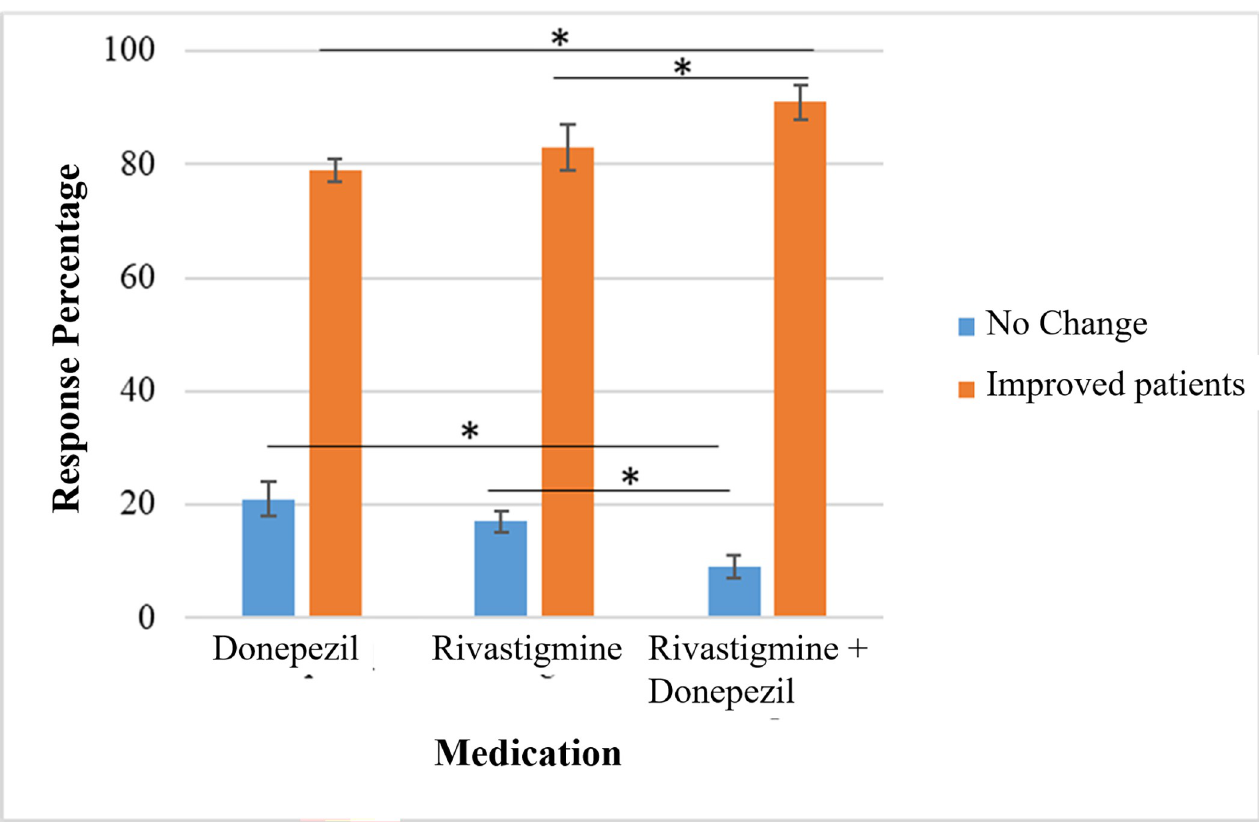
Fig 4. Percentage of improvement in Alzheimer severity scores after acetylcholinesterase inhibitors (AChEIs) medications were given to the patients. No significant difference reported between Donepezil treatment group and Rivastigmine treatment group in the degree of improvement in severity scores. On the other hand, severe cases of Alzheimer showed a more significant increase after using a Donepezil and Rivastigmine combined therapy than using a single medication. Each column represents the percentage of severity score improvement ± standard error of the mean (SE). � P < 0.05 ( t